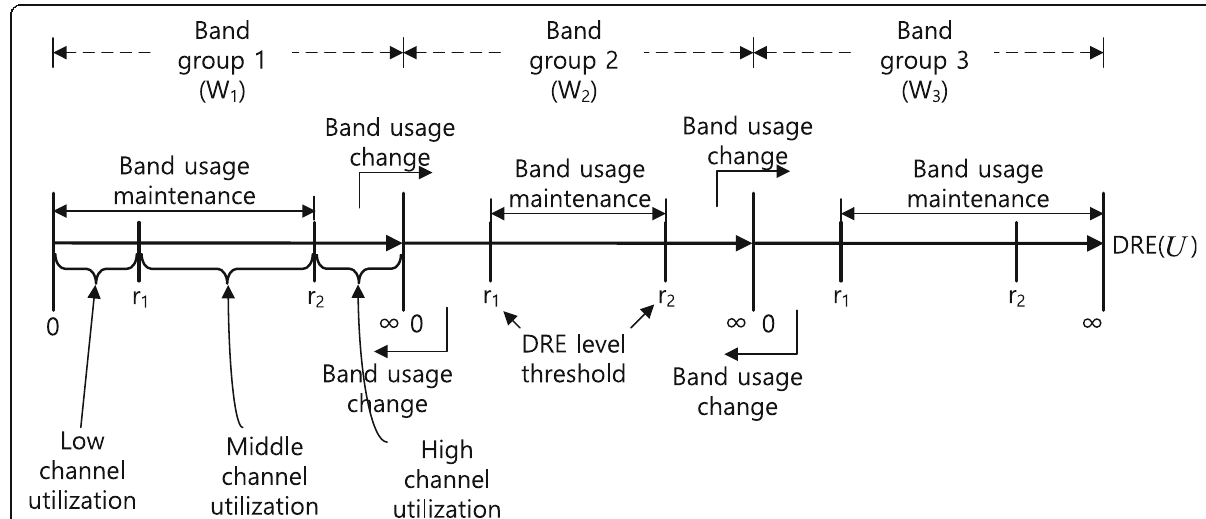
Fig. 7 Band group movement mechanism according to DRE. It is assumed the bandwidth of each channel provided by each band group follows W 1 < W 2 < W 3 . The x -axis represents the DRE of each band group. The DRE is low, moderate, and high if it belongs to [0, r 1 ), [ r 1 , r 2 ), and [ r 2 , ∞ ). If the DRE is low, the selection of the band need to be changed to lower one since the selected band supports too much bandwidth. However, the CH could not change the band in the range of [0, r 1 ) in band group 1 since there is no band to move. If the DRE is high, the selection of the band need to be changed to a higher one since the selected band does not support the DDR. However, the CH could not change the band in the range of [ r 2 , ∞ ) in band group 3 since there is no band to move. In the range of [ r 1 , r 2 ) in each band group, the system does not need to change the band since the selected band supports adaptive bandwidth. Therefore, the whole DRE region is divided by the region of “ Band usage